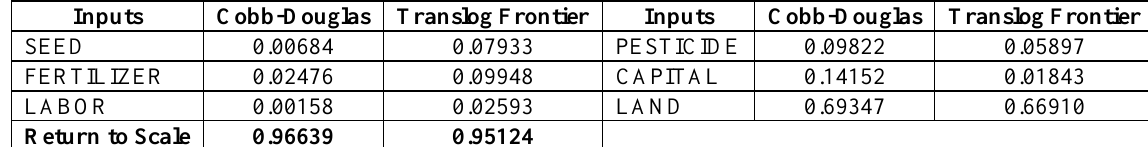
Table 6: Output elasticities of inputs used in cotton